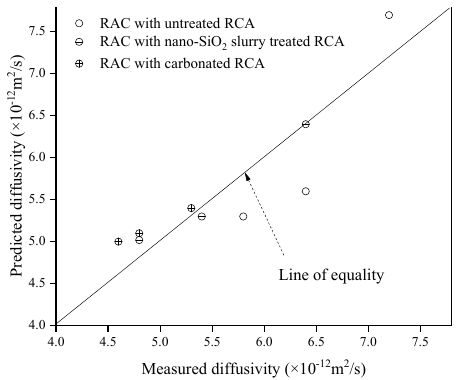
Figure 11. Comparison between the test results and theoretical prediction of RAC.